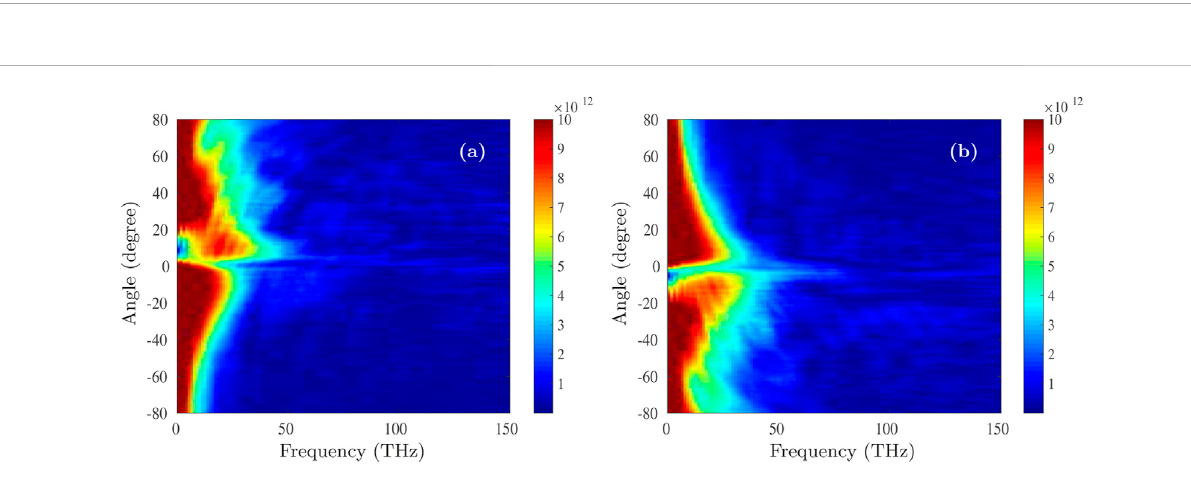
behind the target is collected by a semi-circle centered at (100 λ 0 , 0) in the ( x , y ) plane because it can be seen as a point source radiating outward over time [30, 31, 36]. We choose the radius of the detected semi-circle to be R 0 = 45.0 μ m, which is enough to